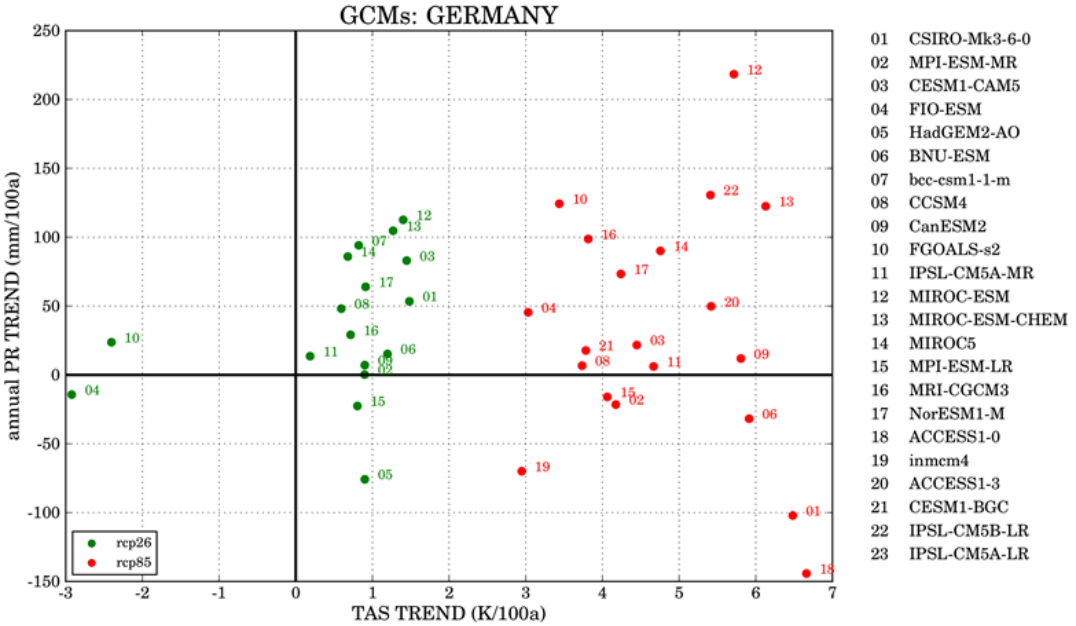
Figure 10. Scatterplot of potential temperature and precipitation change in different global climate models [43]. (copyright Peter Hoffmann, PIK)